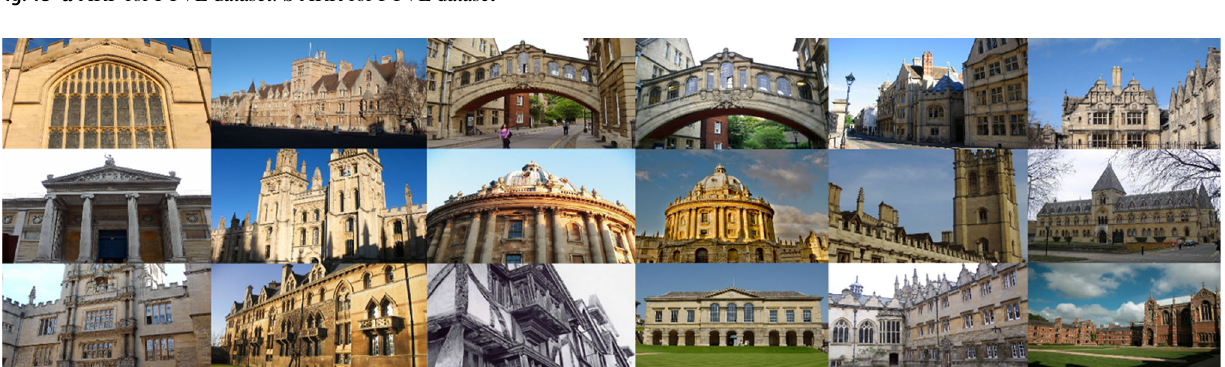
(a) ARP for FTVL dataset (b) ARR for FTVL dataset Fig. 13 a ARP for FTVL dataset. b ARR for FTVL dataset